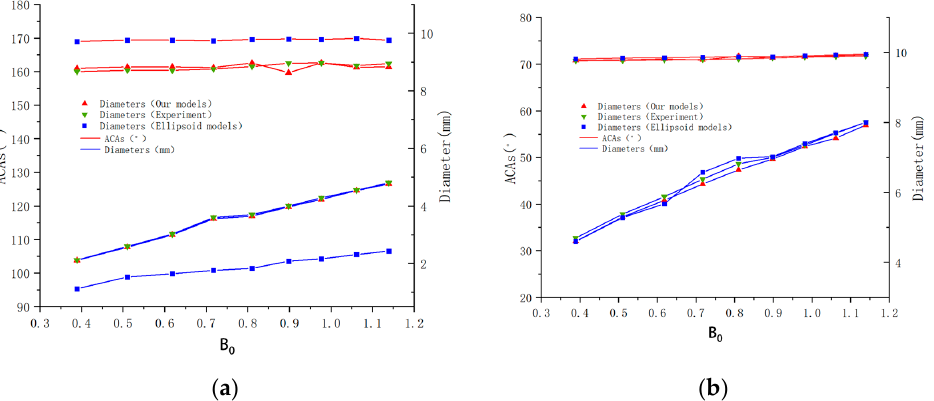
Figure 8. Comparations among results from our model, from experiments and from the ellipse model with different droplet Bond numbers. ( a ) The horizontal microstructured plane (Types 1, 2 and 3) and ( b ) the smooth external spherical surface (Type 7, 8 and 9).